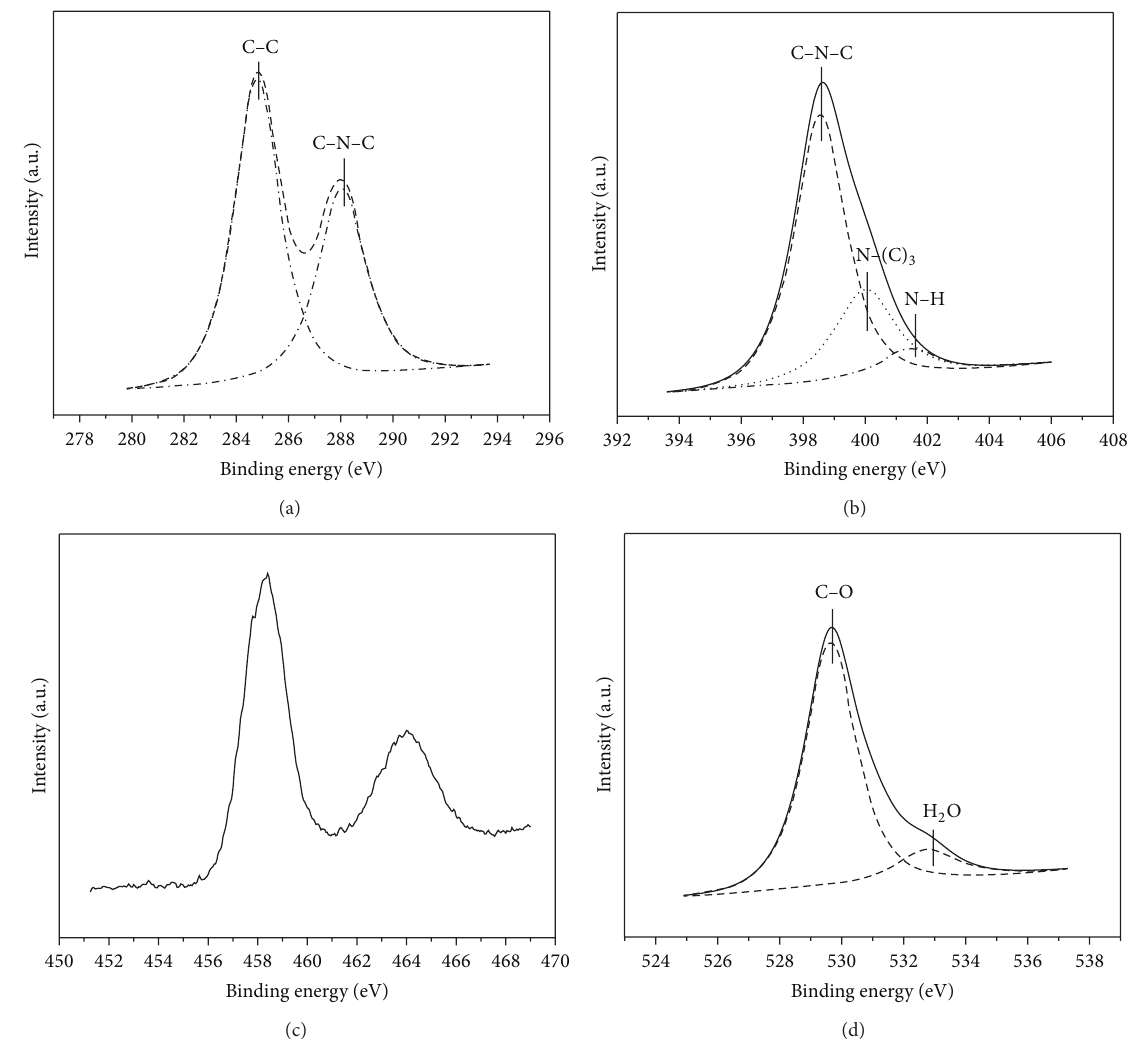
Figure 4: XPS spectra of the as-prepared C 3 N 4 coated TiO 2 nanocomposite under 450 ∘